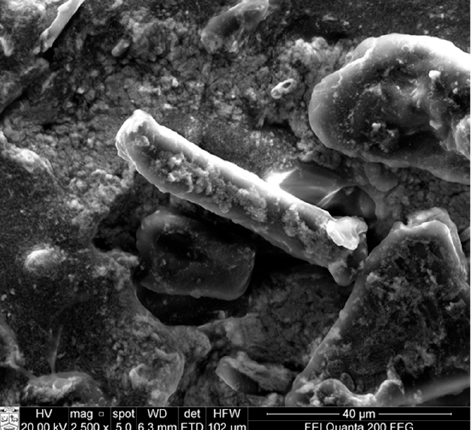
Figure 10. SEM image of PDMS/MCC composites with 20 wt.% of filler tensile fractured surface at magnification of 2500× and 20 KeV.